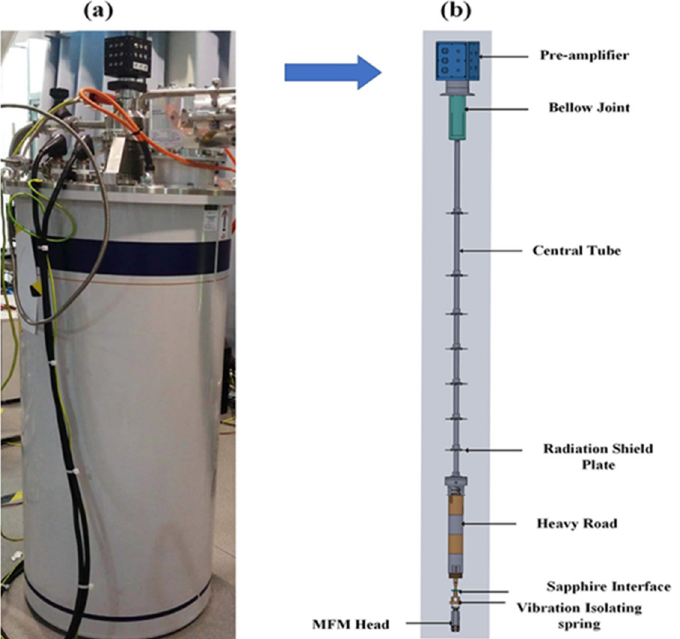
Figure 2. ( a ) Photograph and cross ‐ section of cryogen ‐ free superconducting magnet system and ( b ) photograph of the pre ‐ amplifier board.